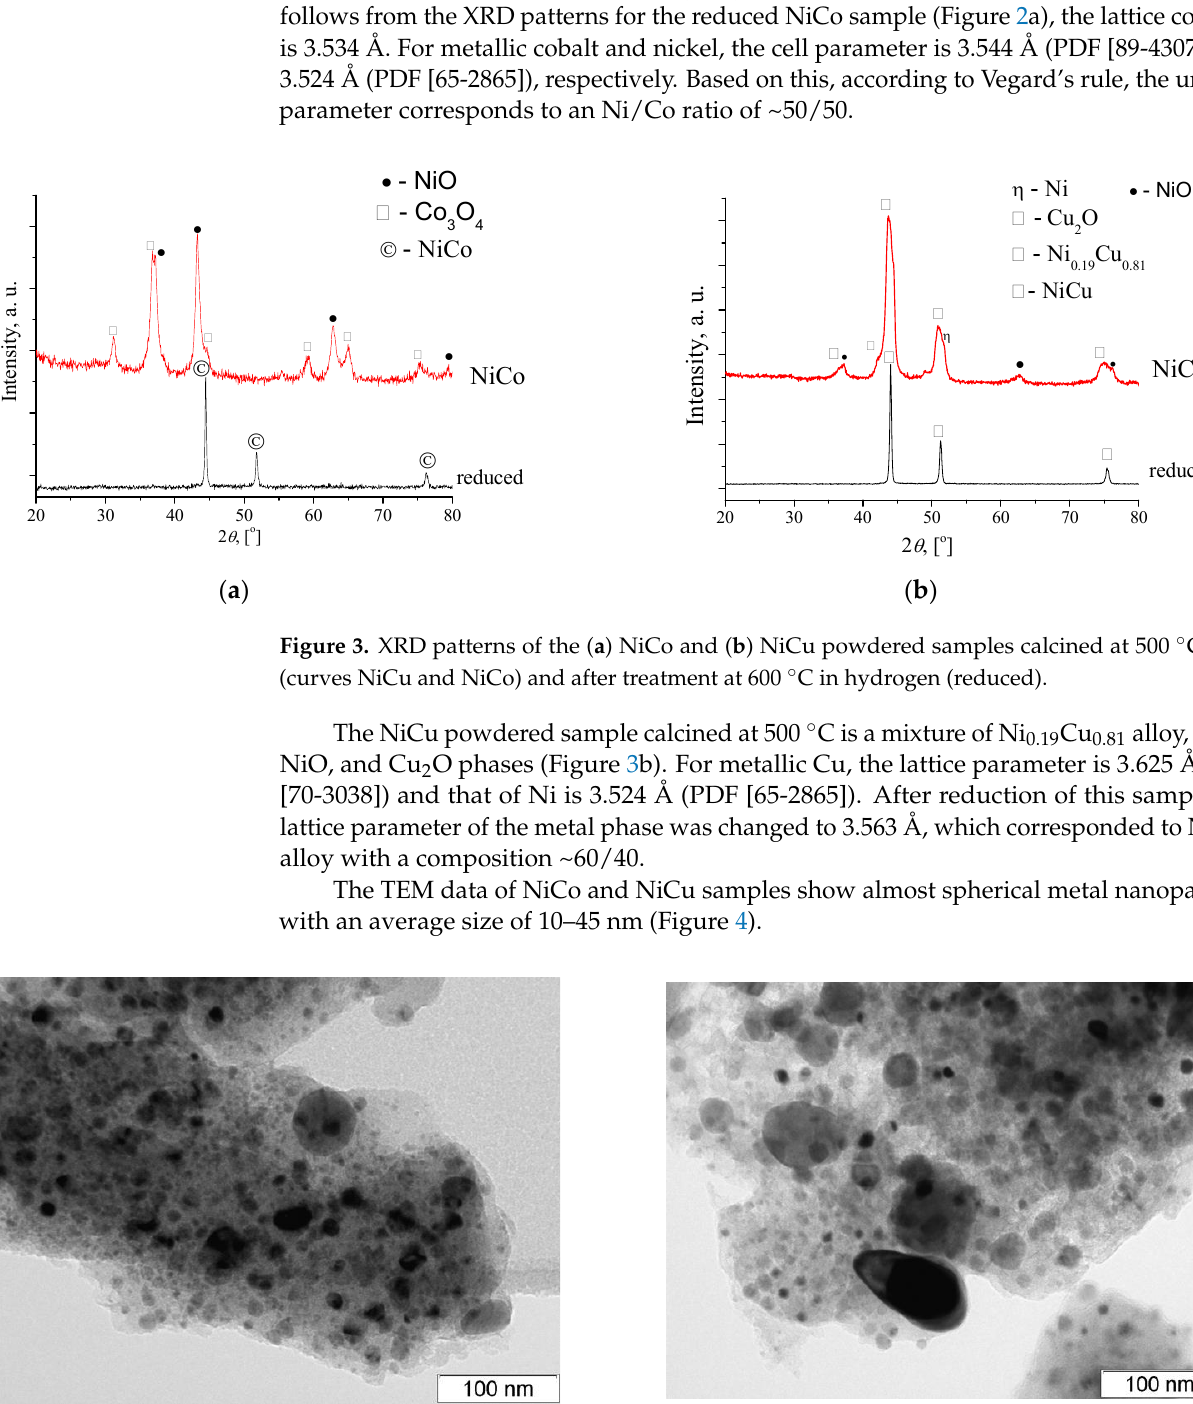
( b ) Figure 5. XRD patterns of the composites NiCo – LCNb ( a ) and NiCu – LCNb ( b ) sintered at 500 – 1100 °C. The nanocomposite NiCu – LCNb (700 °C) consists of monoclinic and tetragonal phases of the composition La 0.99 Ca 0.01 NbO 4 , nickel oxide NiO, and a solid solution of nickel – copper oxide Ni 0.8 Cu 0.2 O x (Figure 5b). Reflections corresponding to a separate cop- per phase or its oxides were not observed; hence, copper compounds are apparently in X- ray amorphous states. There were no new phases indicating products of chemical interac- tion between components of nanocomposites. According to scanning transmission electron microscopy (HAADF-STEM), both sam- ples showed a rather uniform spatial cation distribution (Figures 6 and 7). In the NiCu – LCNb sample, the distribution of lanthanum, niobium, and copper is uniform, but rela- tively large nickel particles are observed. The ratio of nickel to copper depends on the